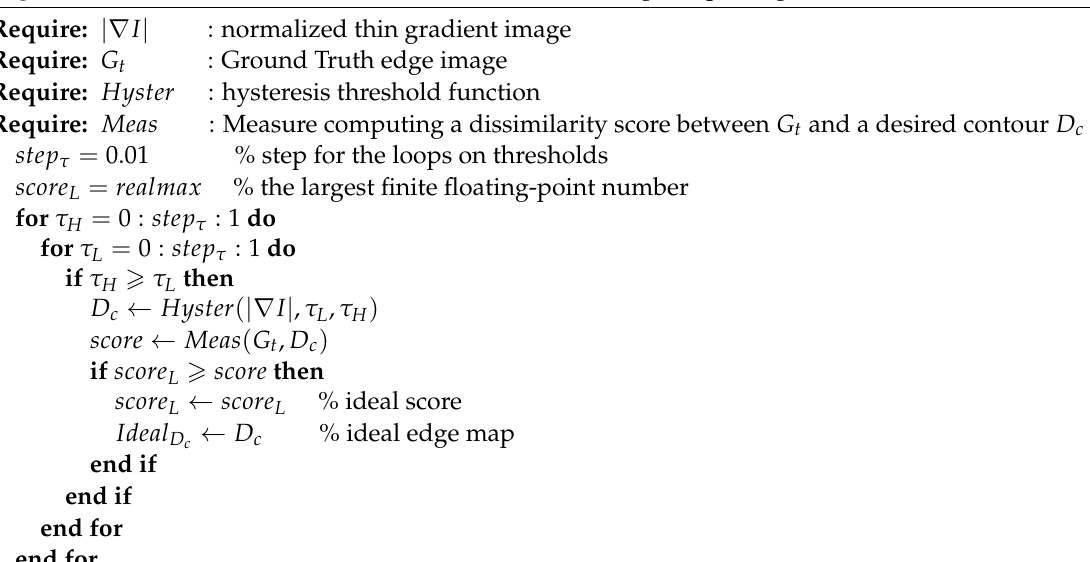
Figure 15. Example of computation of a minimum score for a given measure. Algorithm 1 Calculates the minimum score and the best edge map of a given measure